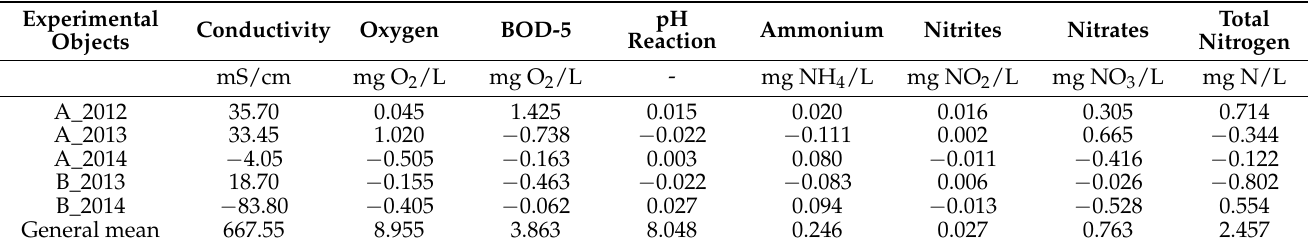
Table 5. Differences between the distinguished experimental objects and the general mean values. Experimental